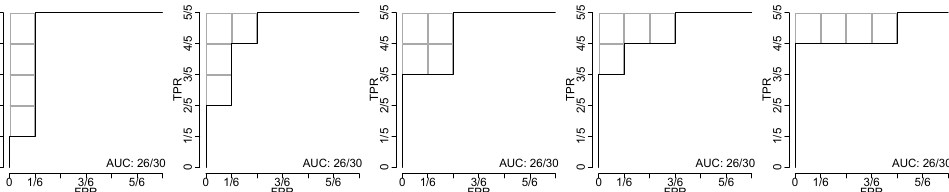
Figure 2. Five ROC-curves yielding the same AUC-value. Illustration of the five distinct ROC- curves that yield the AUC-value 26/30 when the number of TPs and TNs are n = 5 and m = 6, respectively. The gray boxes illustrate the subtracted four rectangles each with area 1/ nm ; hence 1 − 4/ nm =